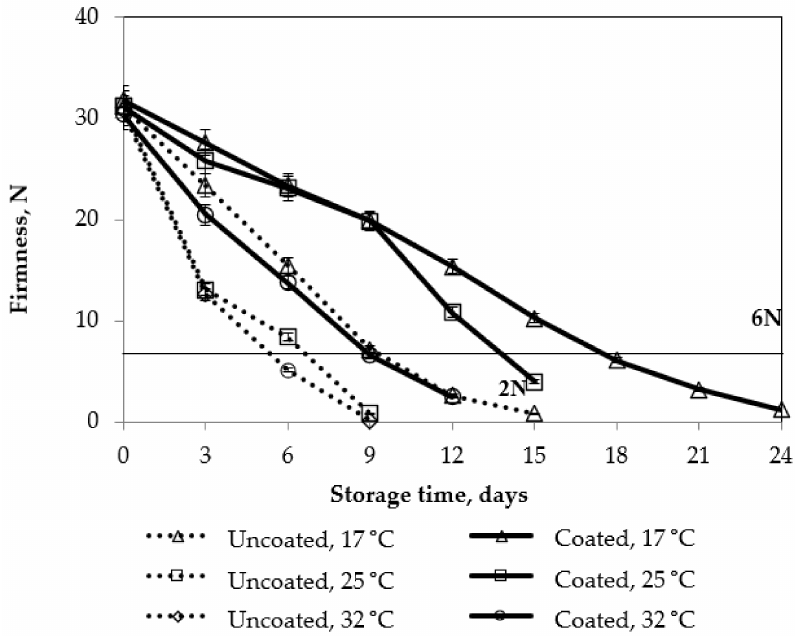
Figure 8. Effect of storage temperature on firmness of mango fruits. Numbers are the mean ± standard errors of three replications.